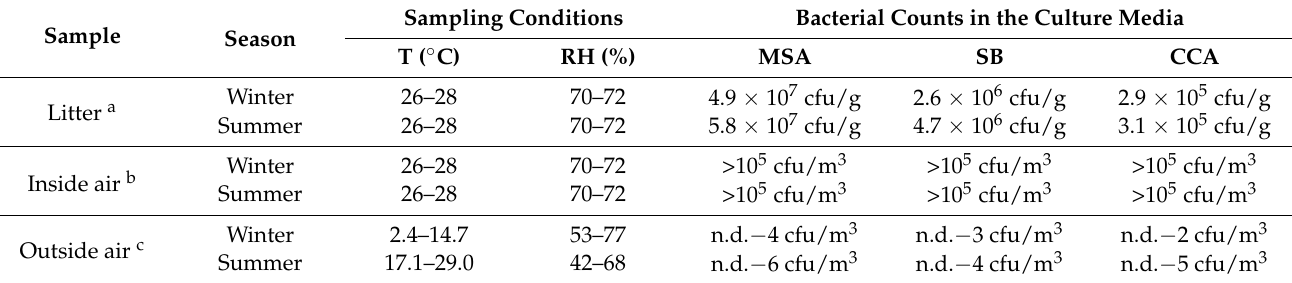
Table 1. Bacterial counts obtained with the mechanical method, in the different types of samples (inside and outside air and litter), in different types of media with indication of sampling